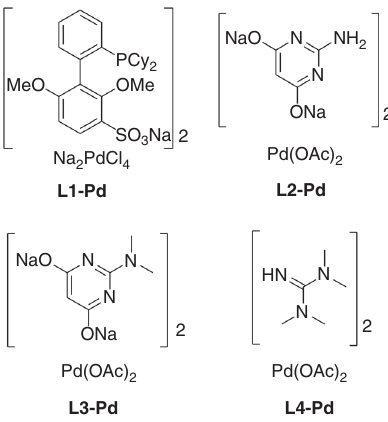
Fig. 2 Selected water-soluble catalysts explored in this study. Catalyst stock solutions were prepared in deionized water, stored at ambient temperature and used within two weeks. L1 - Pd solution were freshly prepared